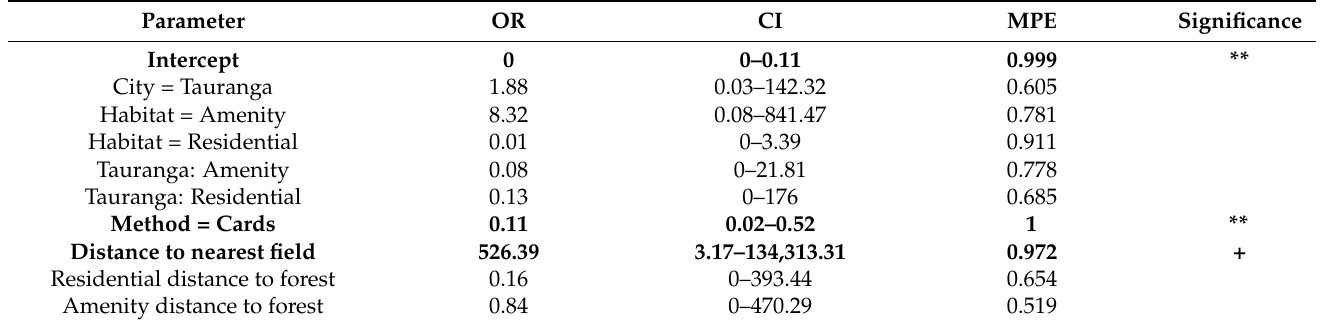
Table 9. Possums: summary statistics for coefficients of the parameters in the two-city possum model fitted to data from New Plymouth and